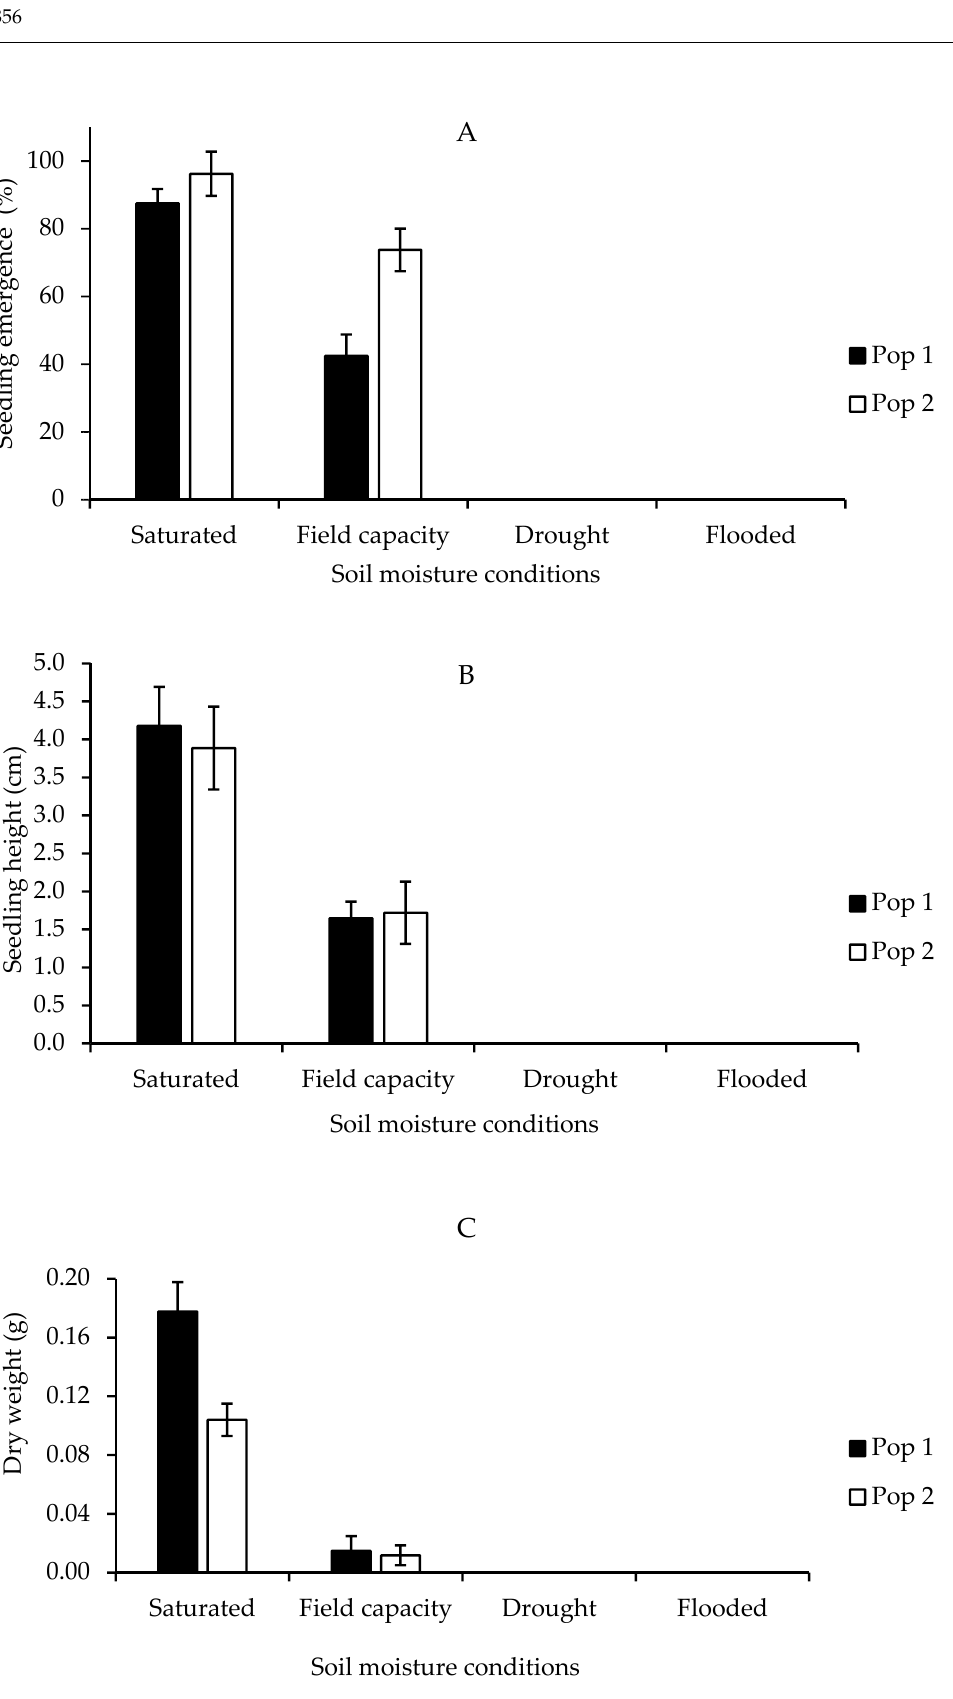
Figure 8. Percentage of seedling emergence ( A ), seedling height ( B ), and seedling dry weight ( C ) of different Parthenium weed populations grown on different soil moisture conditions 30 days after sowing.